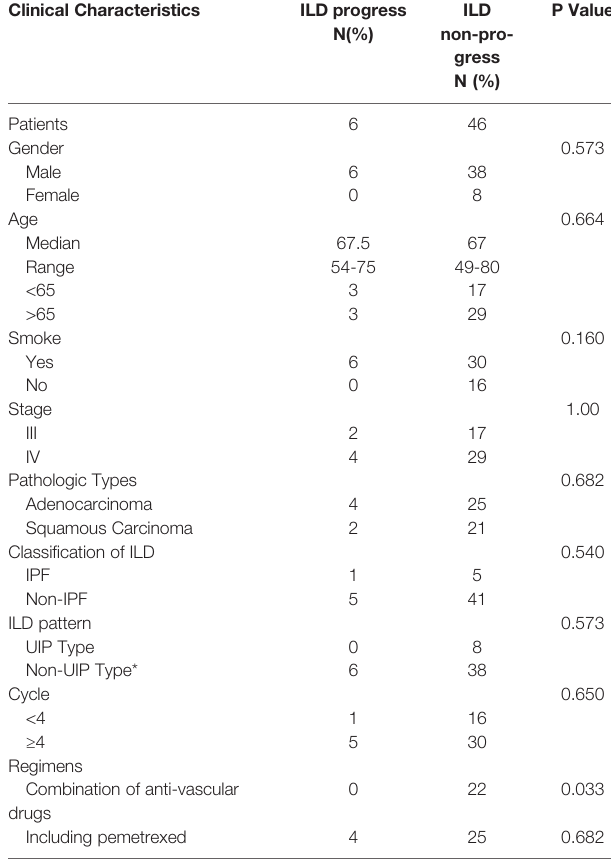
TABLE 3 | Comparison of clinical factors between patients with and without ILD progression. Clinical